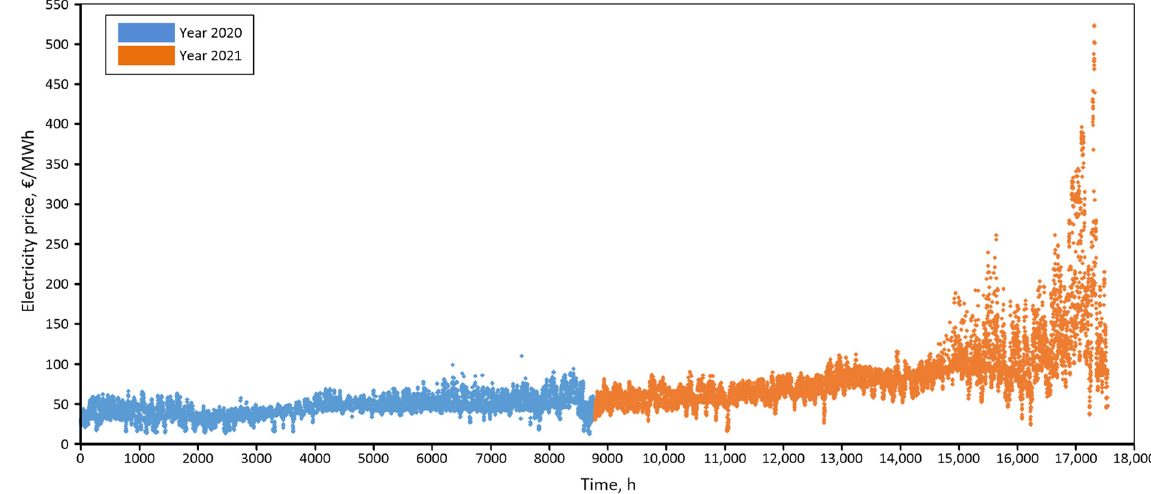
Figure 1. Average hourly electricity prices in Poland in years 2020 and 2021.